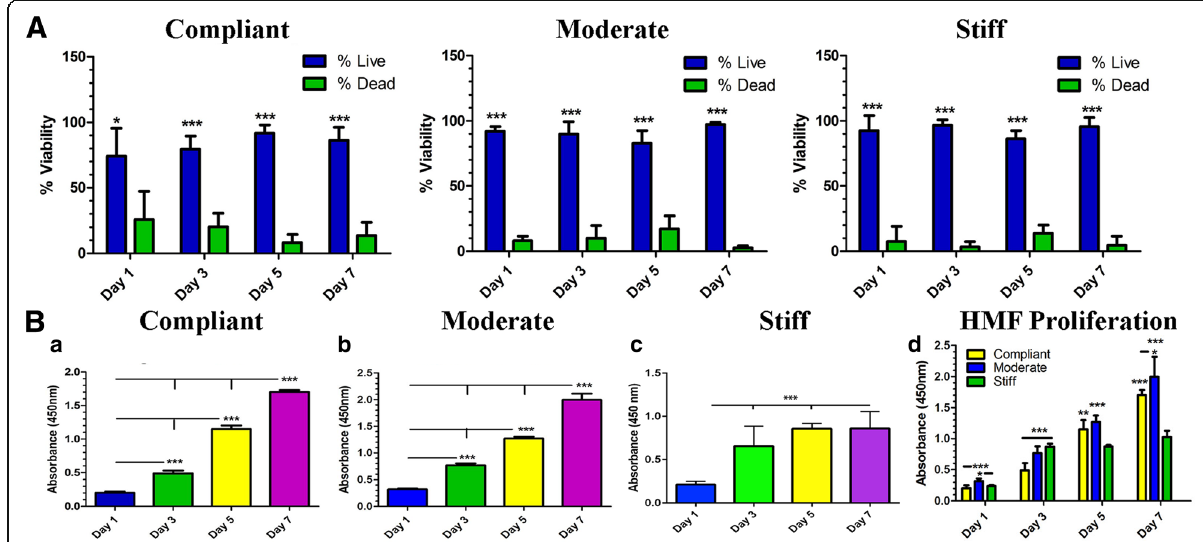
Fig. 5 HMF viability and proliferation encapsulated in mTG hydrogels. HMFs encapsulated in compliant, moderate and stiff hydrogels were assessed for changes in viability and proliferation during the culture period. a Overall, HMFs exhibited significantly greater numbers of live versus dead cells in all hydrogel conditions and at all time points tested. ba,b During the culture period, the rate of HMF proliferation in compliant and moderate hydrogels significantly increased. bc The rate of HMF proliferation in stiff hydrogels increased between days 1 and 5, with no appreciable changes between days 5 and 7. bd Overall, HMFs encapsulated in moderate hydrogels exhibited the most significant changes in proliferation at all time points tested with the exception of day 3. * p ≤ 0.05; ** p ≤ 0.01; *** p ≤